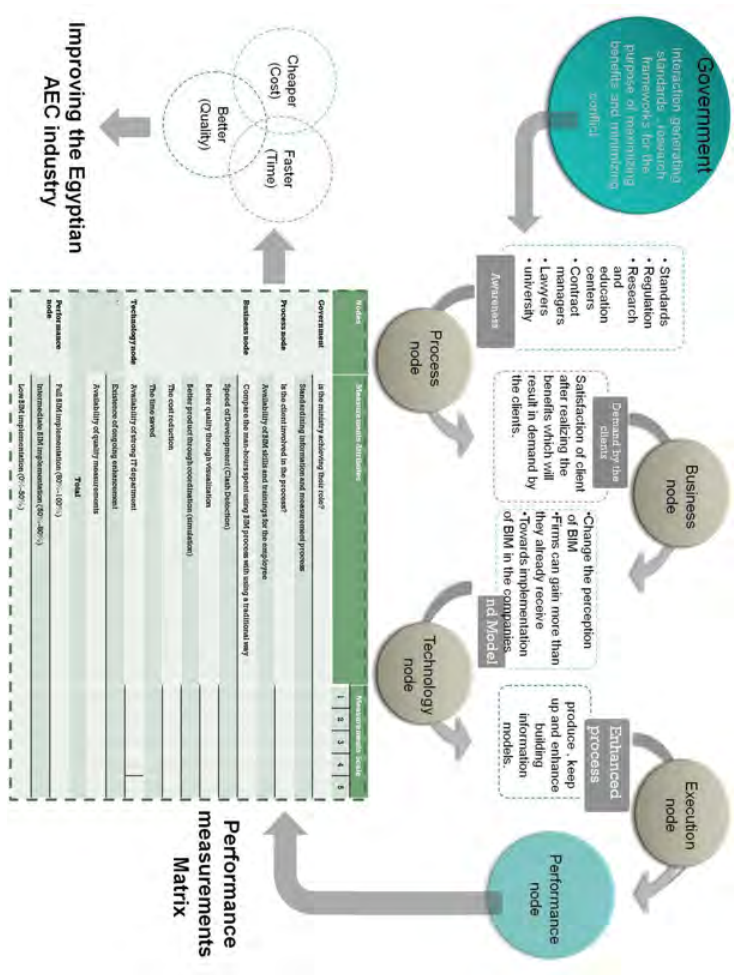
Figure 15. the proposed BIM framework for enhancing theimplementation of BIM in Egypt, generated by the